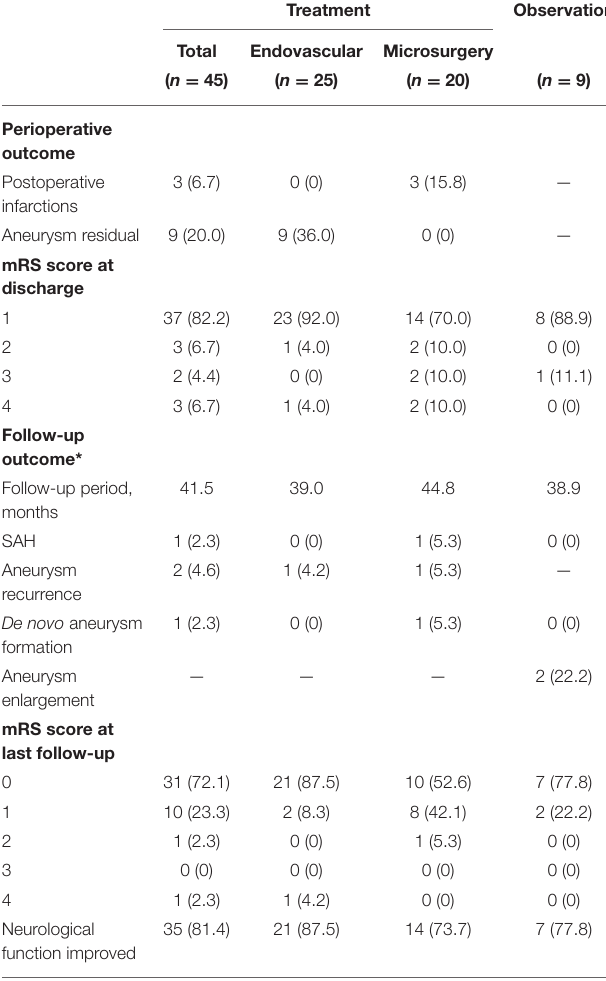
TABLE 4 | Perioperative and follow-up outcomes of paediatric aneurysms. Treatment